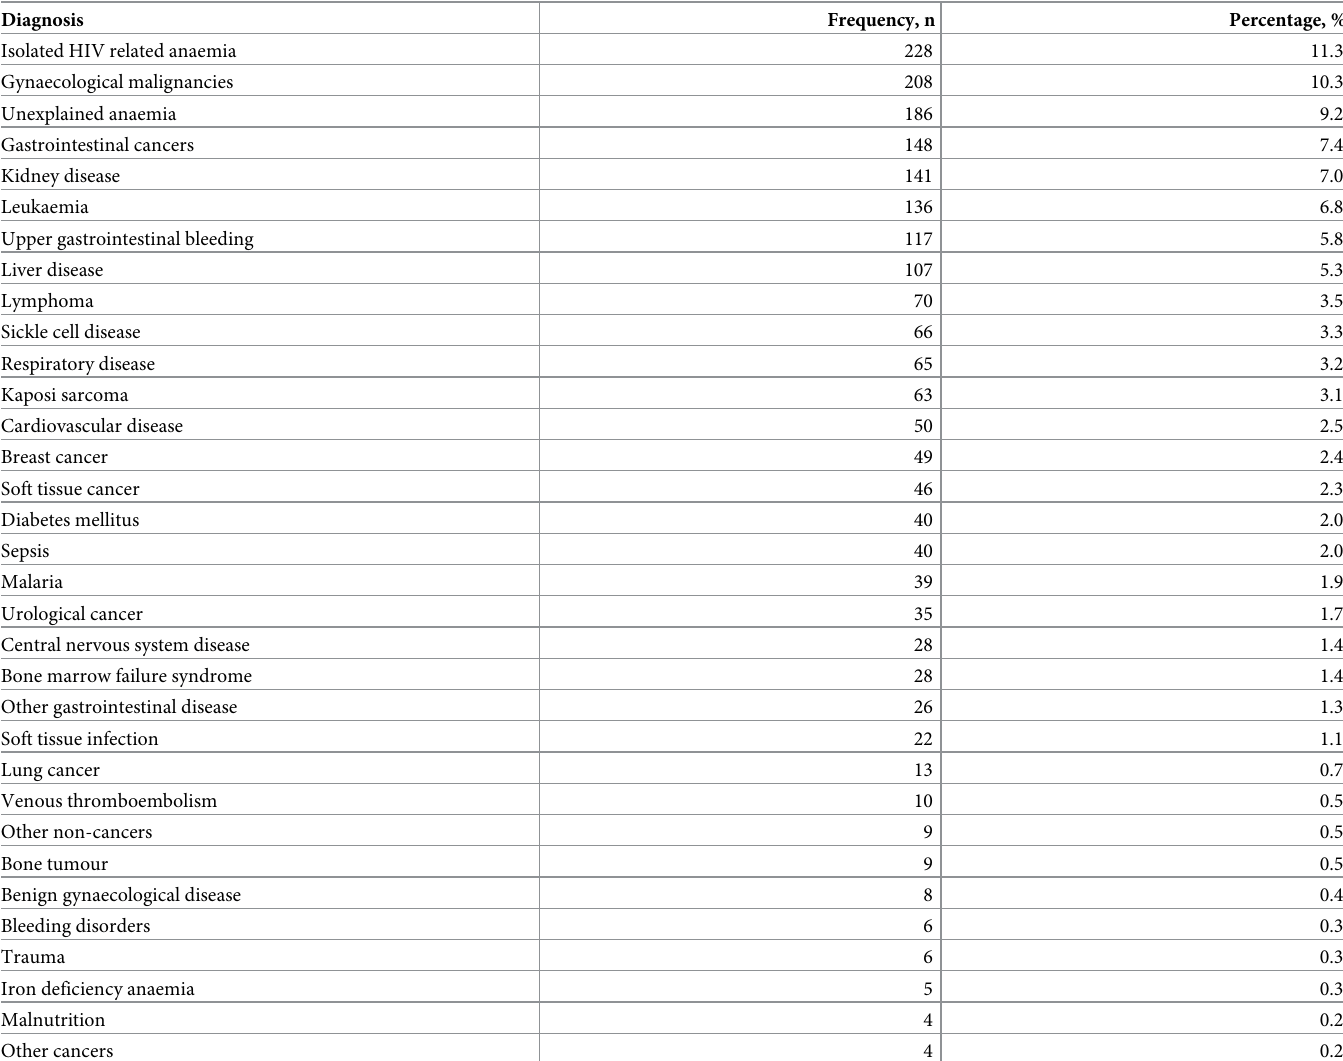
Table 1. Baseline patient